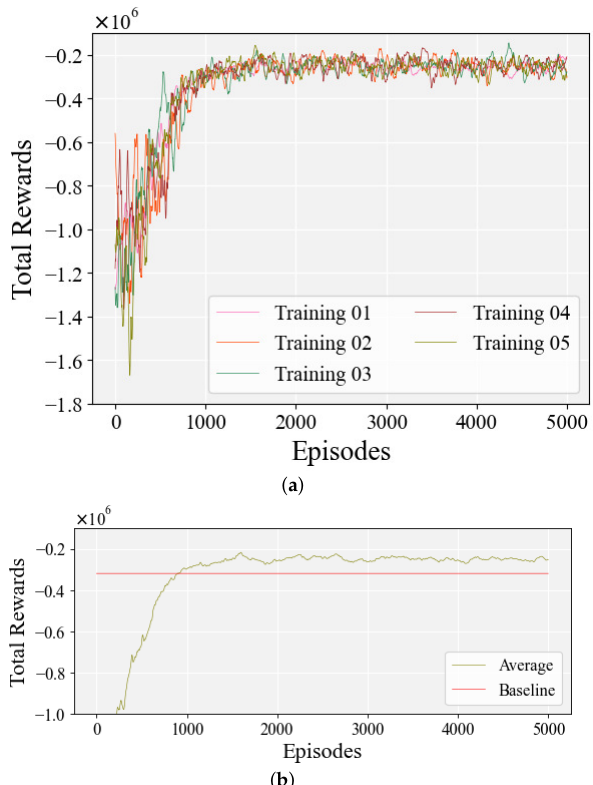
Figure 14. The learning process of KA-DDPG without the criteria action method: ( a ) total rewards for each learning process and ( b ) the average value of the total